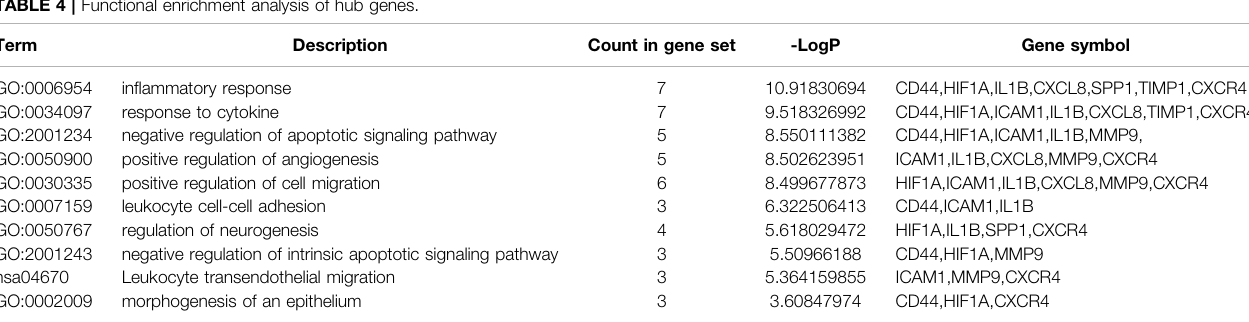
TABLE 4 | Functional enrichment analysis of hub